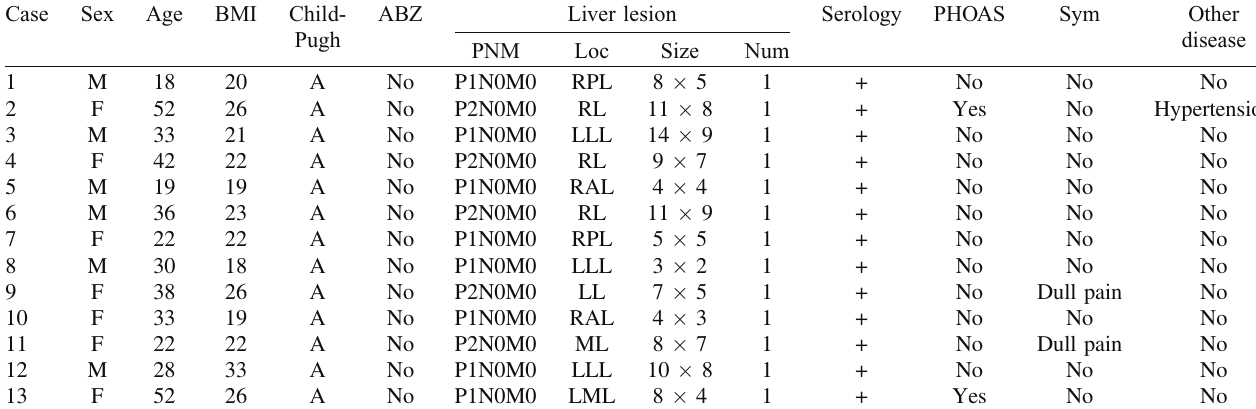
Table 1. Baseline information for 13 patients.